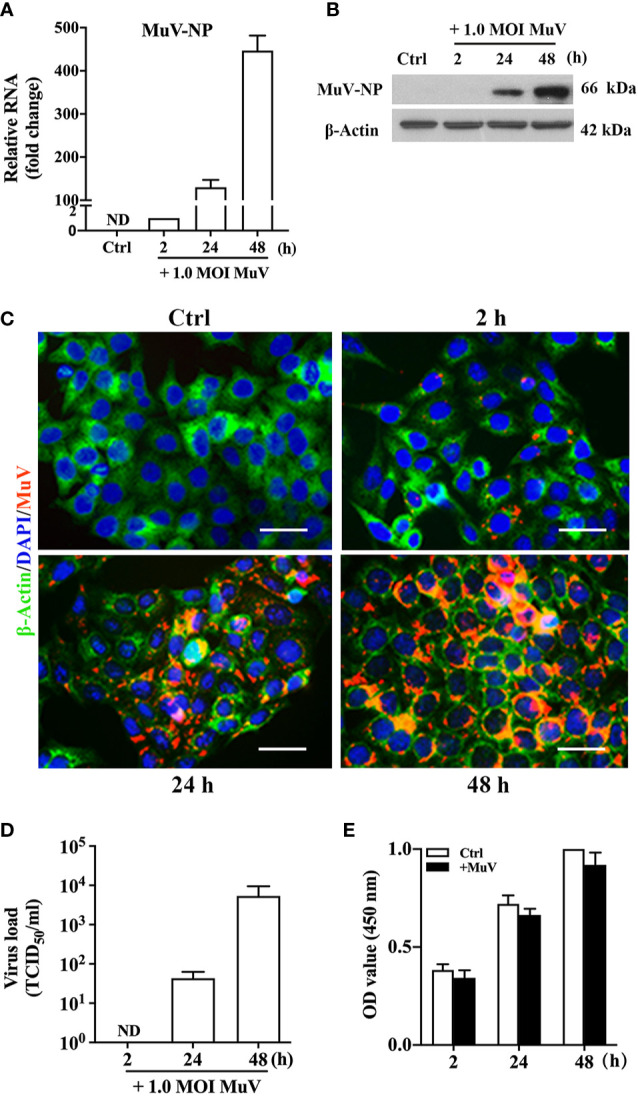
MuV replication in HeLa cells. (A) Time-dependent MuV replication. HeLa cells were infected with MuV at a MOI of 1.0, and cells without MuV infection served as controls (Ctrl). Total RNA was extracted at specific times after infection, and the relative RNA levels of MuV-NP were analyzed using real-time qRT-PCR. (B) Protein levels of MuV-NP. HeLa cells were infected with MuV as described in (A). At the indicated time-points after infection, MuV-NP protein levels in the cellular lysates were determined using Western blot analysis. (C) Intracellular MuV-NP. HeLa cells were infected with MuV as described in (A). We determined intracellular distribution of MuV-NP (red) using immunofluorescence staining. The cytoplasm and nuclei were localized by immunofluorescence staining for β-Actin (green) and DAPI (blue). (D) Viral loads. HeLa cells were infected with 1.0 MOI MuV for the indicated periods of time. MuV loads in culture medium were determined using a TCID50 assay. (E) Cell viability. After infection with MuV at a MOI of 1.0 for the indicated durations, the HeLa cell viability was determined using the CCK-8 assay. Images represent at least three independent experiments. Data are presented as means ± SEM of three separate experiments. Scale bar = 20 μm. ND, not detectable.